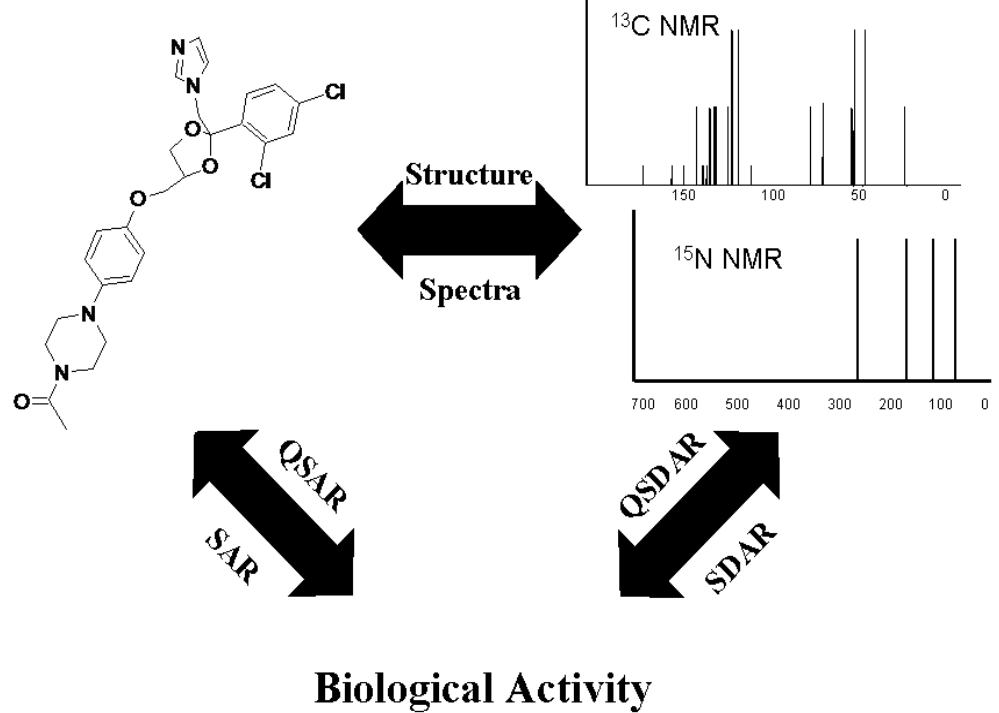
Figure 1. Triangular relationship between the structure, 13 C- and 15 N-NMR spectral data, and biological activity. Kectoconazole is used as an